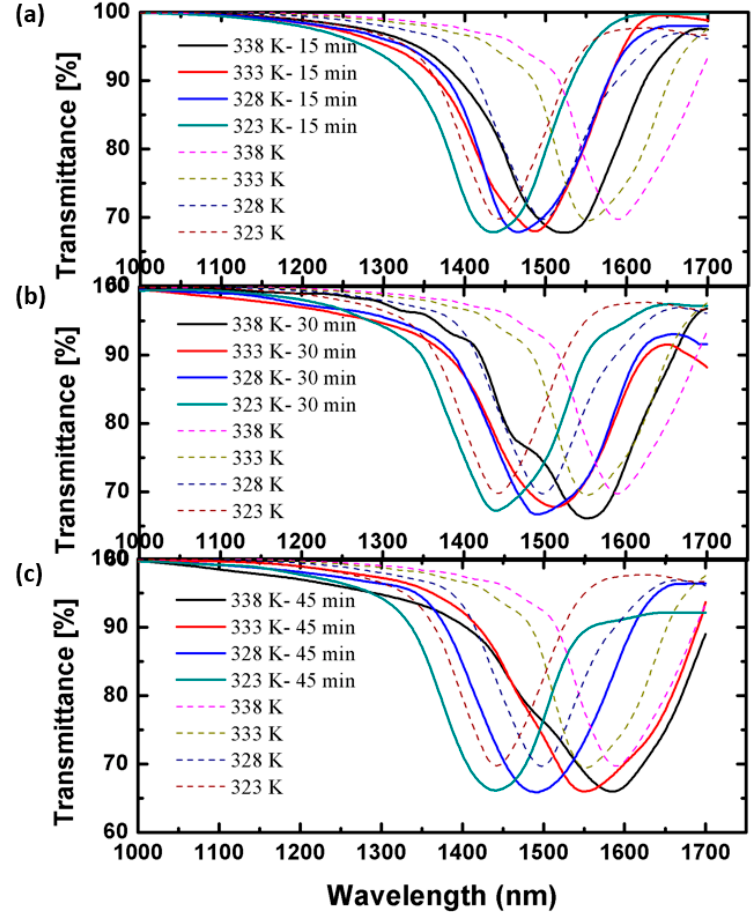
Figure 2. Transmission spectra of polymer-stabilized cholesteric liquid crystal (PSCLC) filters under different polymerization conditions. Results of polymerization at 323 K with holding treatment at different temperatures for ( a ) 15 minutes, ( b ) 30 minutes, and ( c ) 45 minutes.